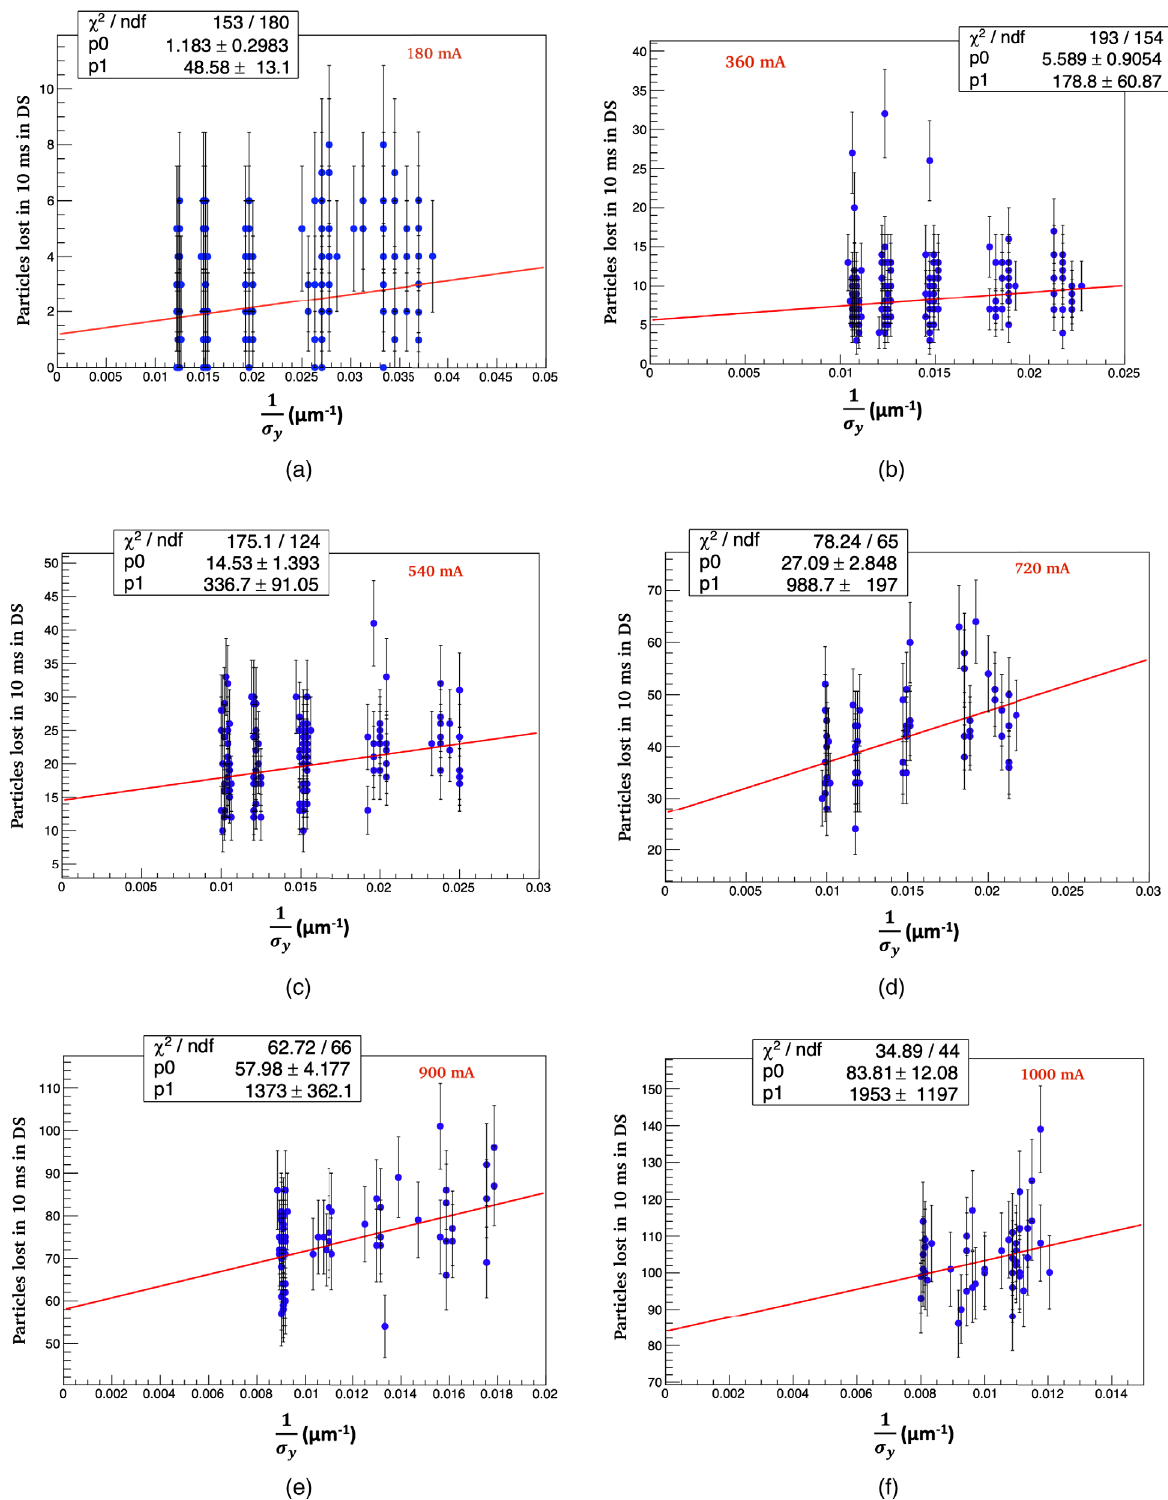
FIG. 17. Fit of the measured losses in the sCVD as a function of the inverse of the vertical beam size at different beam currents marked in red inside each